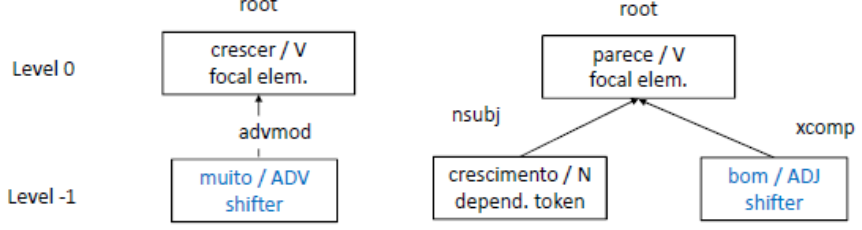
Figure 3. Two examples with dependency links between some